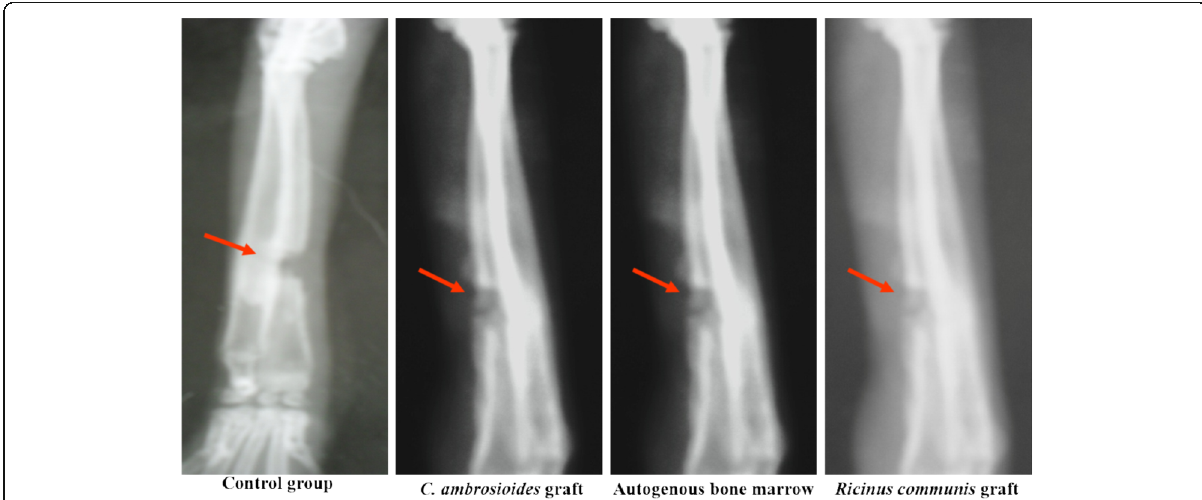
Fig. 1 Effect of a graft of lyophilized aqueous Chenopodium ambrosioides L. extract on bone formation. Radiographs showing bone callus evolution after 30 day. Control group and Ricinus communis graft bone defect exhibiting the absence of a fibrous bone callus. C. ambroioides graft and Autogenous bone marrow bone defect exhibiting the beginning of formation of a fibrous bone